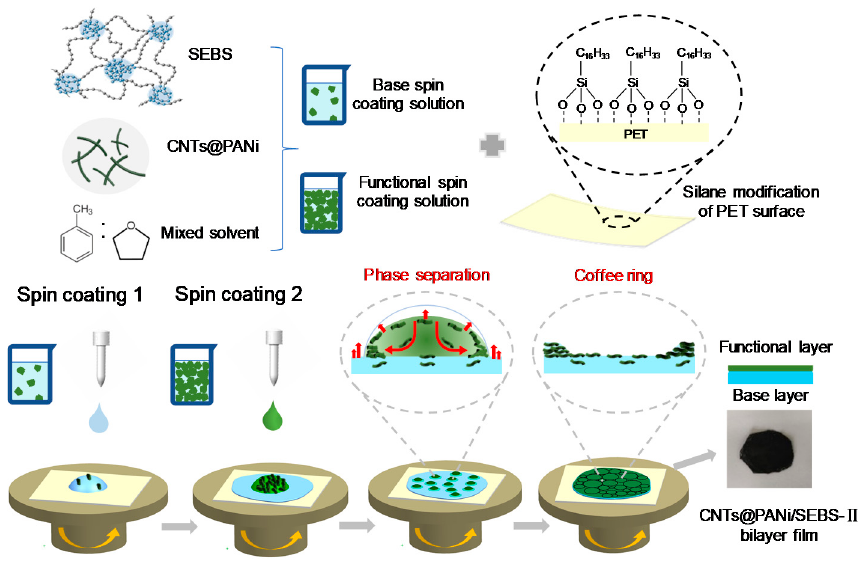
Figure 1. Schematic diagram of the preparation process of CNTs@PANi / SEBS-II bilayer film and the formation mechanism of coffee ring structure.